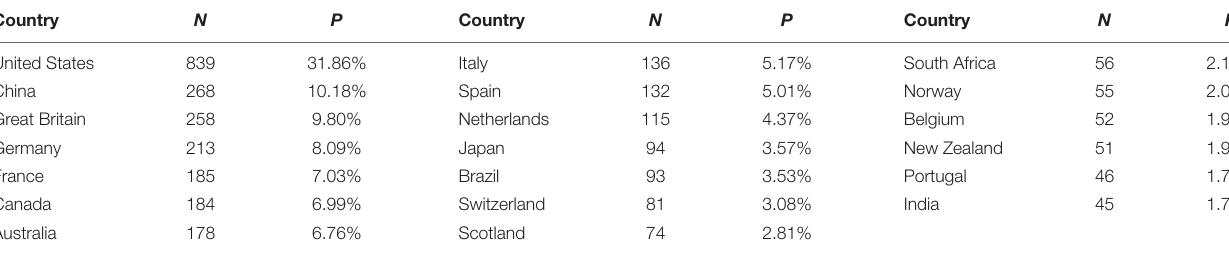
TABLE 1 | Distribution by country of literature on citizen environmental behavior (top 20). Country